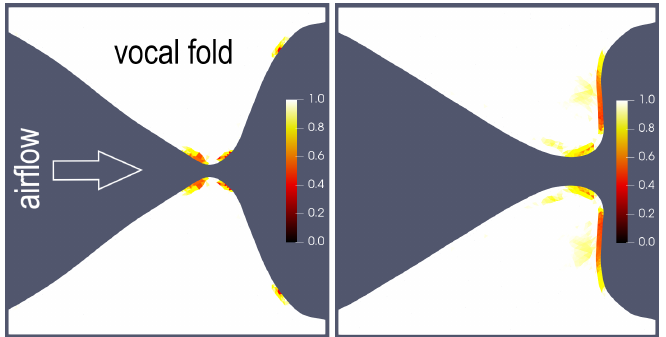
Figure 11. Details of VFs deformations and the ratios R of the norms of linear and nonlinear strain tensors for the smallest and the largest glottal gap. Computed by the neo-Hookean elasticity